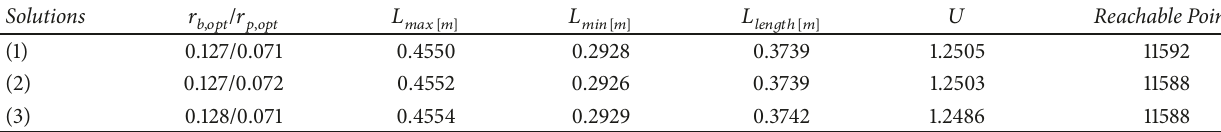
Table 7: Leg lengths for optimum parameters of the